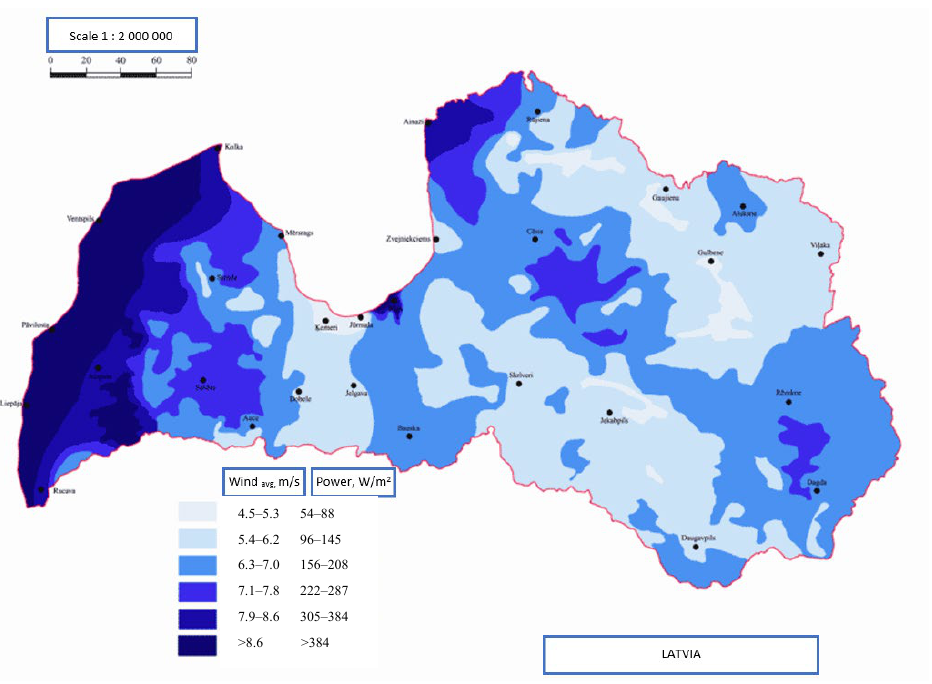
Fig. 1. Average wind speed in Latvia at the height of 100 meters